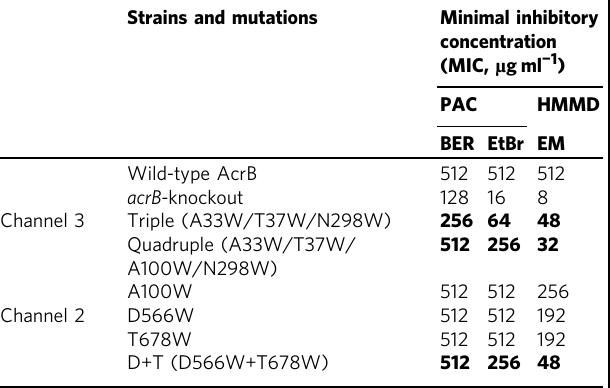
Table 2 Liquid MIC values for CH3 and CH2 mutant AcrB expressing MG1655 Δ acrB E. coli cells Strains and mutations Minimal inhibitory